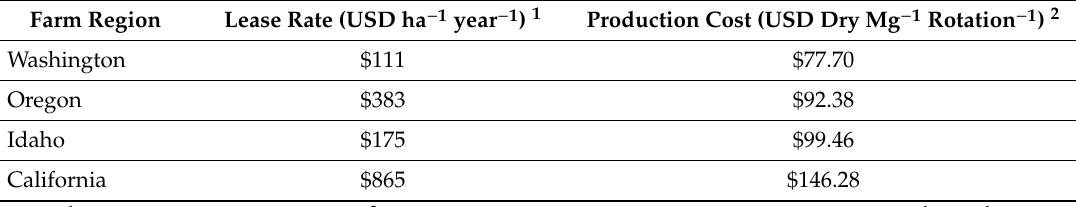
Table 3. Land and biomass productions costs for Advanced Hardwood Biofuels Northwest (AHB) poplar demonstration farms throughout a 20-year rotation of seven harvest